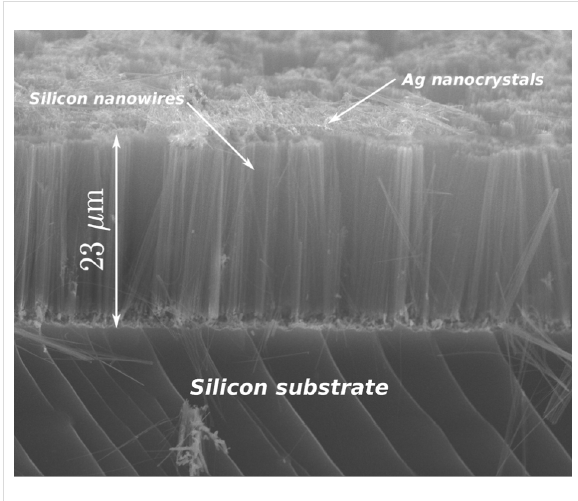
Figure 15: SEM image of a silicon nanowire “forest” (cross-section), fabricated by MaCE of silicon in an HF/AgNO 3 aqueous solution.